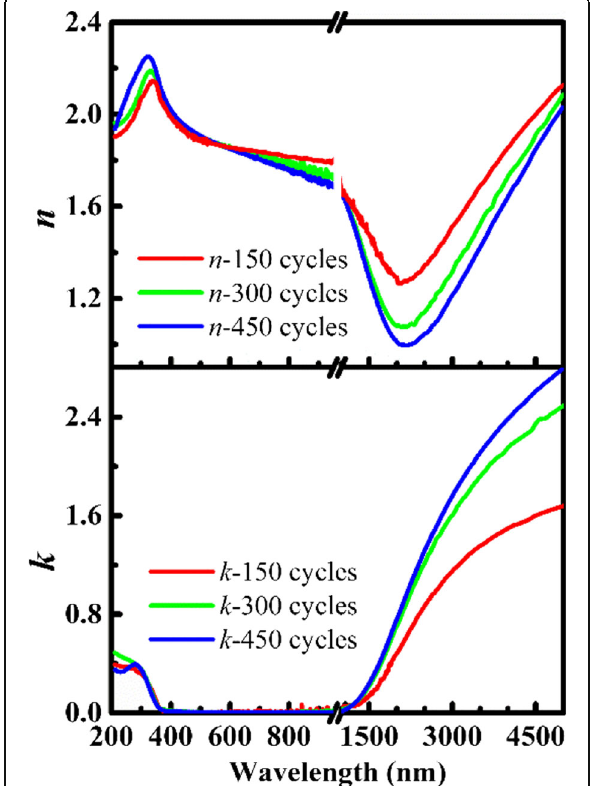
Fig. 1 Refractive index ( n ) and extinction coefficient ( k ) were simulated by point-by-point analysis using the data from SE measurements